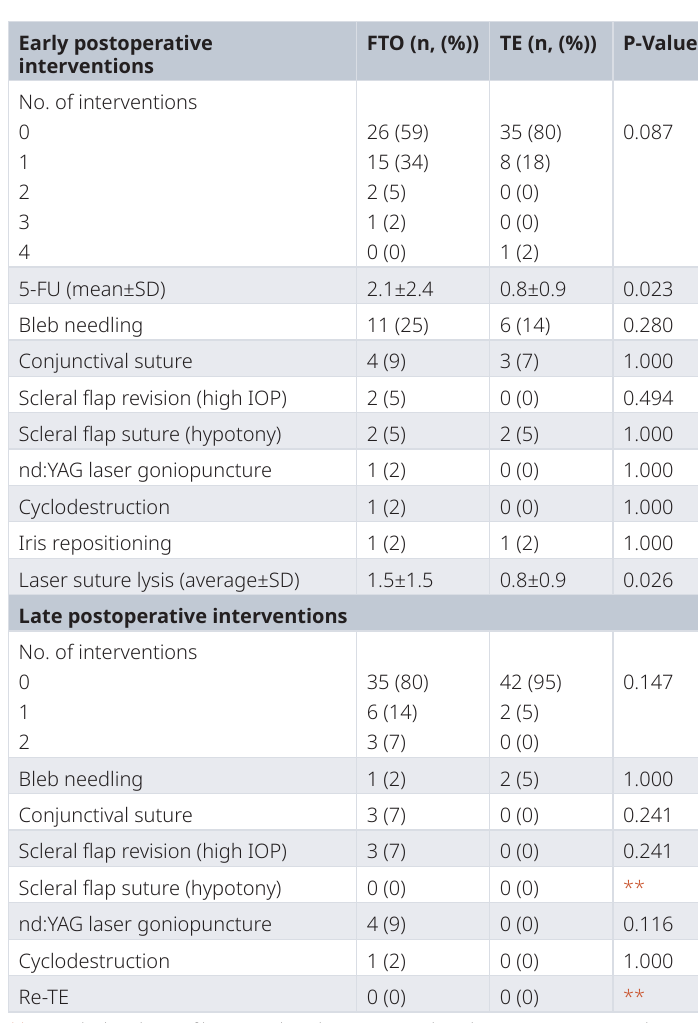
Table 3. Postoperative interventions in FTO and TE.